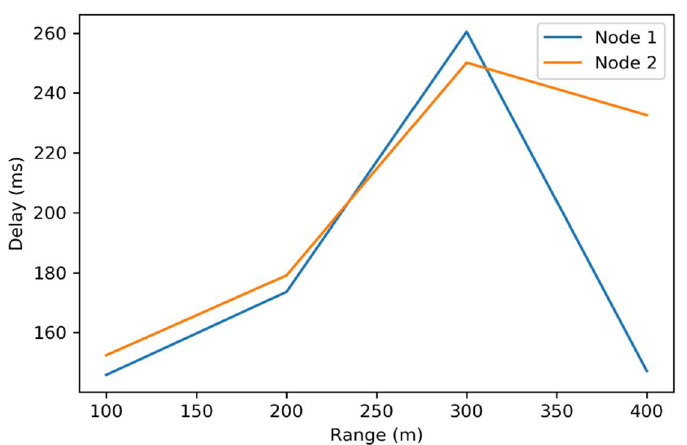
Figure 8. Delay graph from default parameters.